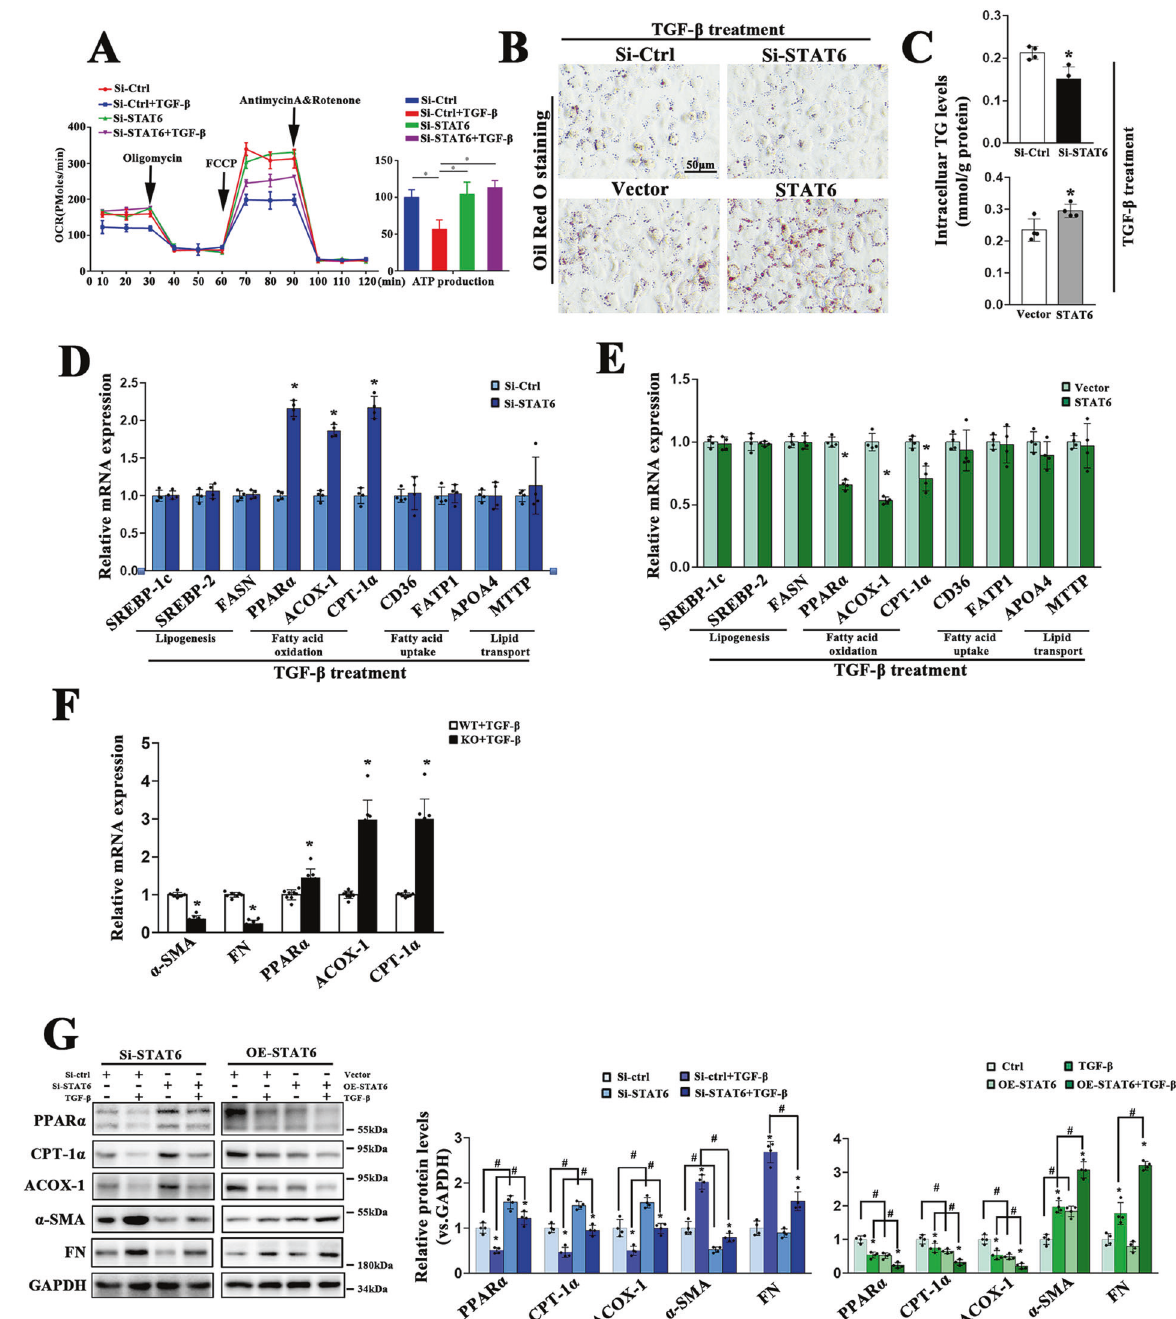
Fig. 4 STAT6 in tubular cells suppresses PPAR α -mediated fatty acid oxidation. HK2 cells were transfected with siRNA or plasmid for STAT6 inhibition or overexpression. Followed by 24 h serum-free medium culture, the cells were treated with TGF- β (5 ng/ml) for another 24 h. A Representative traces of three independent experiments for the measurement of oxygen consumption rate (OCR) were shown. Oligomycin, FCCP, and antimycin/rotenone were administrated at the indicated time point. ATP production was determined according to the OCR values. Data are presented as mean ± SD ( n = 3, * P < 0.05). B Representative micrographs for Oil Red O staining of HK2 cells treated as indicated ( C ) TG content was determined enzymatically. D , E mRNA levels of genes related to lipid metabolism in STAT6 inhibited or overexpressed HK2 cells were determined by qRT-PCR. Results are expressed as the mean ± SD ( n = 4 * p < 0.05, SiCtrl/Vector vs . SiSTAT6/STAT6 transfection) F mRNA levels of genes related to FAO and fi brotic proteins expression in primary renal tubular epithelial cells isolated from the above Stat6 WT and cKO mice. Results are expressed as the mean ± SD ( n = 4, * p < 0.05, Stat6 WT vs . Stat6 cKO). G HK2 cells were transfected with indicated siRNA or plasmid for 24 h in serum-free medium and followed by TGF- β (5 ng/ml) treatment for another 24 h. Cell lysates were harvested and subjected to immunoblot analyses with the indicated antibodies. Quanti fi cation of relative protein expression was determined. Results are expressed as the mean ± SD ( n = 4, * p < 0.05, Ctrl vs . TGF- β ; # p < 0.05, SiCtrl/Vector vs .SiSTAT6/STAT6 transfection).